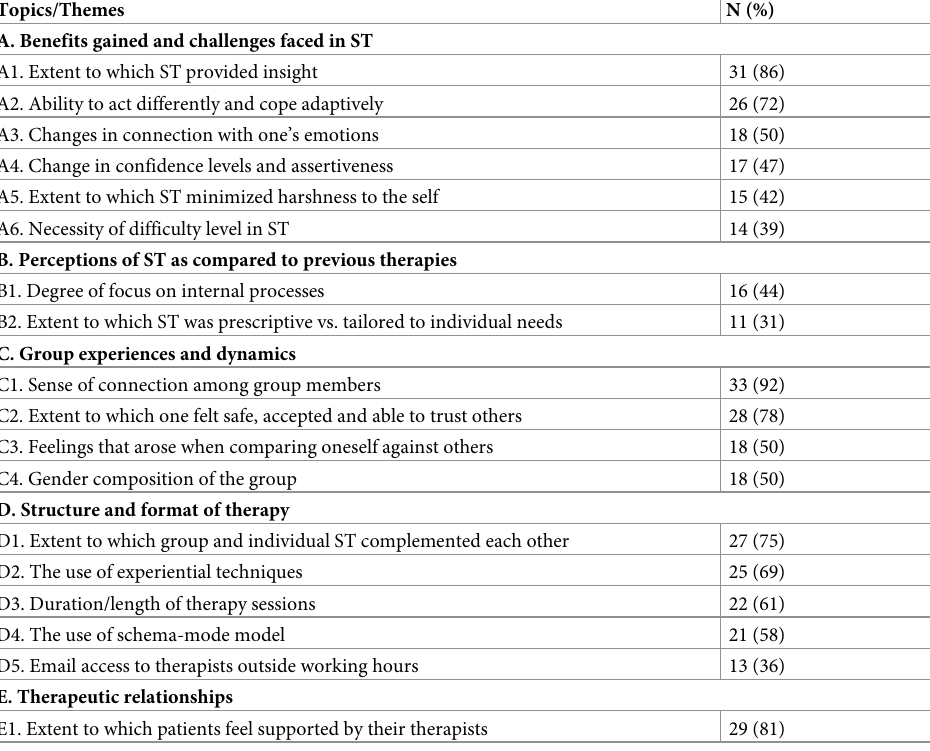
Table 3. Broad perceptions of group and individual components of schema therapy.